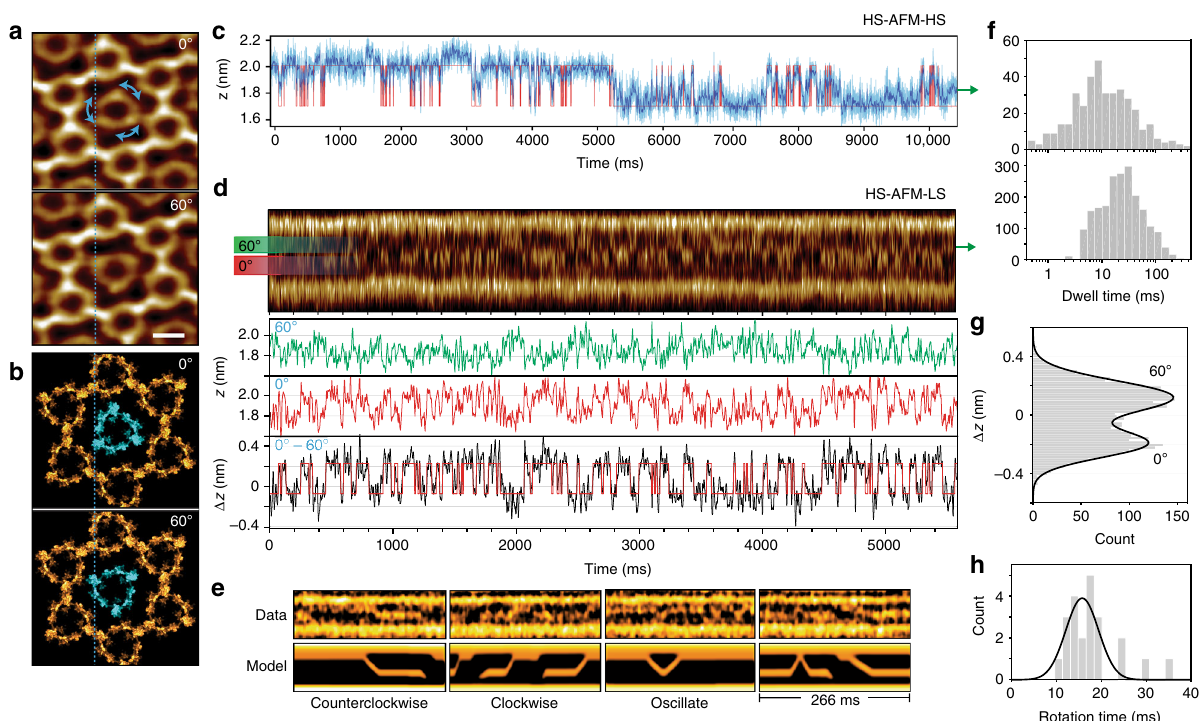
Fig. 5 HS-AFM-HS and line scanning of A5 rotation. a Averaged HS-AFM images and b structural models, of the A5 trimer at the center of the hexagonal p 6-lattice, captured in its two preferred orientations 0° and 60° (Supplementary Movie 1). Scale bar: 5 nm. c Height/time trace obtained from HS-AFM-HS measurements on one protomer of the rotating A5. Data were captured at 655 kHz (light blue) and was overlaid with fi ltered data over 30 points (dark blue) and an idealized two state trace (red). d Line scanning kymograph across one A5 protomer captured at 2.4 ms per line. Labels 60° and 0 ° (see in a) indicate the x -positions where the height/time traces below, in green and red respectively, were obtained. The anti-correlation of the two positions allows the height/time signal difference between the height traces at 0° and 60° to be plotted (black trace) and fi tted with a two-state model (red trace). e Line scanning kymographs (top), and example model kymographs of rotations between the two preferred orientations (bottom). f Distribution of dwell-times spent in each orientation before rotation, with overlaid normalized survival plots obtained by HS-AFM-HS (upper panel) and line scanning (lower panel). Histograms each contain data from 3 different trimers each showing no signi fi cant statistical differences between molecules. g Histogram of the height differences obtained by subtracting height/time traces at 0° and 60° in d . h Rotation time histogram ( n = 22) of single resolved 60° clockwise and counter-clockwise rotations in